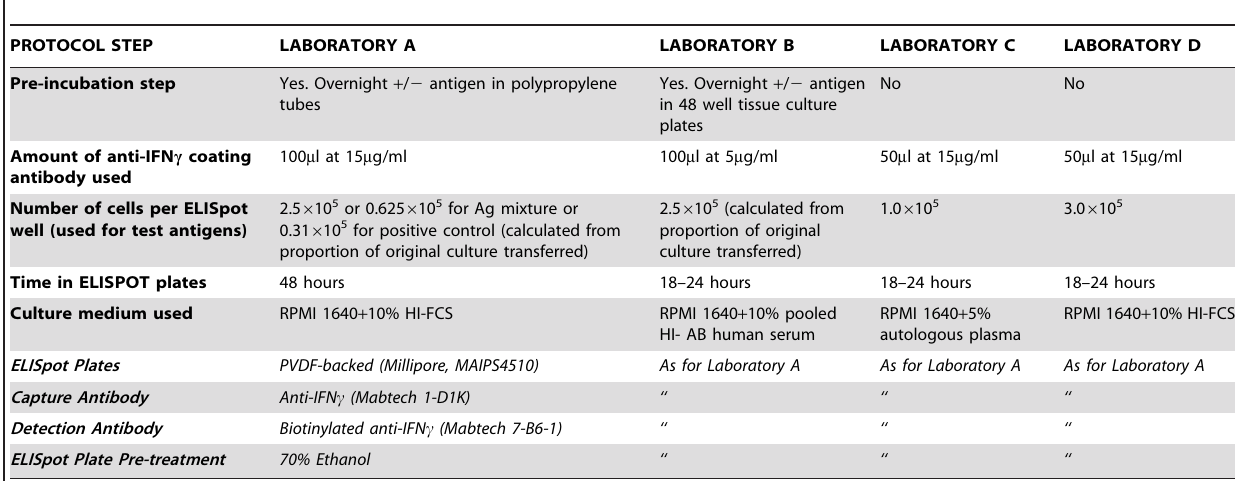
Table 1. Major differences ( and similarities ) in ELISpot protocols submitted by 4 participant